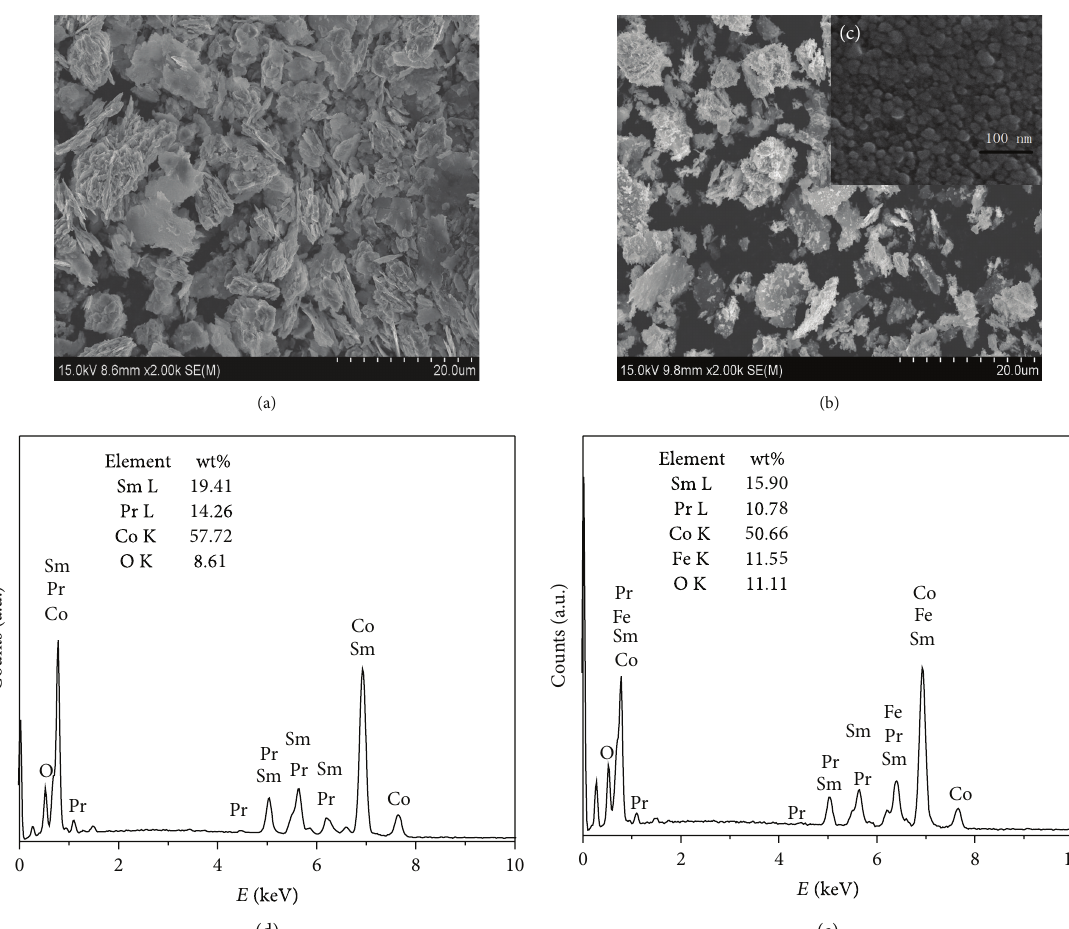
Figure 1: SEM micrographs and EDS spectrum of (Sm,Pr)Co 5 powders and (Sm,Pr)Co 5 /Fe nanocomposites. (a) (Sm,Pr)Co 5 powders after ball milling for 4 h; ((b) and (c)) (Sm,Pr)Co 5 /Fe nanocomposites for different magnifications; ((d) and (e)) EDS spectrum of (Sm,Pr)Co 5 and (Sm,Pr)Co 5 /Fe nanocomposites and the element mass